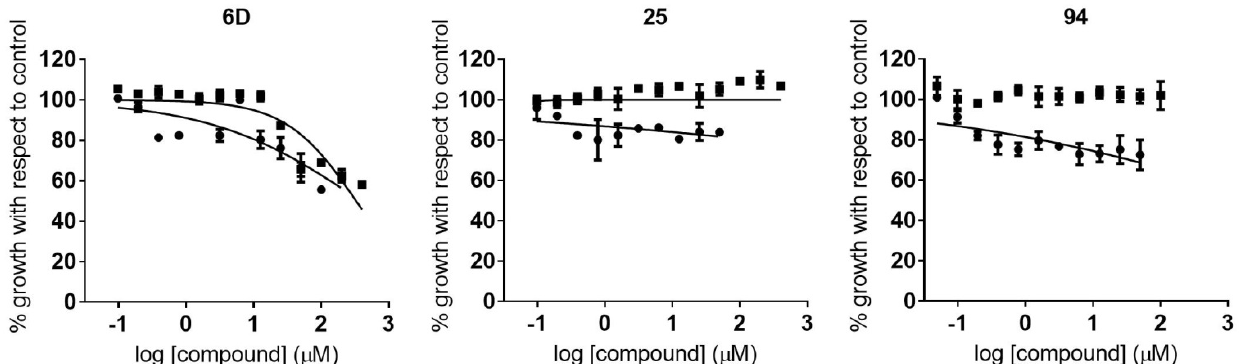
Figure 5. Dose–response curves of some of the active compounds against P. falciparum and T. cruzi in Vero and HepG2 cell toxicity assays. Vero cell toxicity assays are represented by circles, whereas HepG2 cell toxicity assays are represented by squares. Graphs represent mean values and SD results of at least three independent replicas.